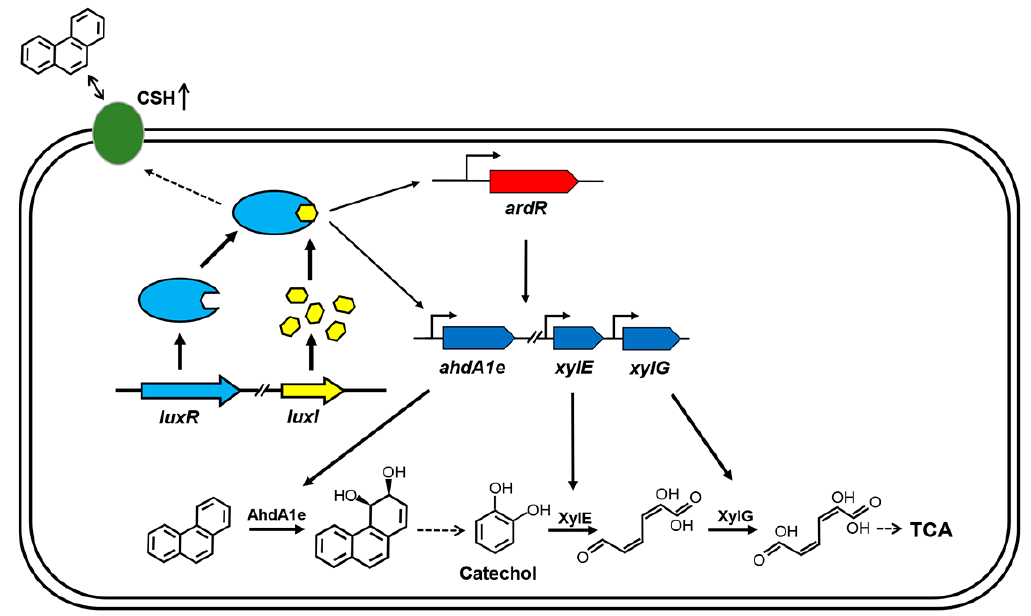
Figure 6. Model for QS regulation on phenanthrene degradation in C. naphthovorans PQ-2. The QS system positively regulates PAH degradation via multiple mechanisms. The LuxR-AHL complex may bind to the “ lux box” and then directly regulate the transcriptional levels of three PAH-degrading genes, including ahdA1e , xylE and xylG . The LuxR-AHL complex may also indirectly modulate the expression of these PAH-degrading genes, which is mediated by the transcriptional regulator ArdR. Moreover, the QS system enhances bacterial cell surface hydrophobicity (CSH), thus affecting the attachment of cells to PAHs. Similar to other AHL-type QS systems, the LuxR-AHL complex in PQ-2 has a positive feedback effect on the expression of luxR and luxI . For clarity, the secretion and uptake of AHLs are omitted in the model.